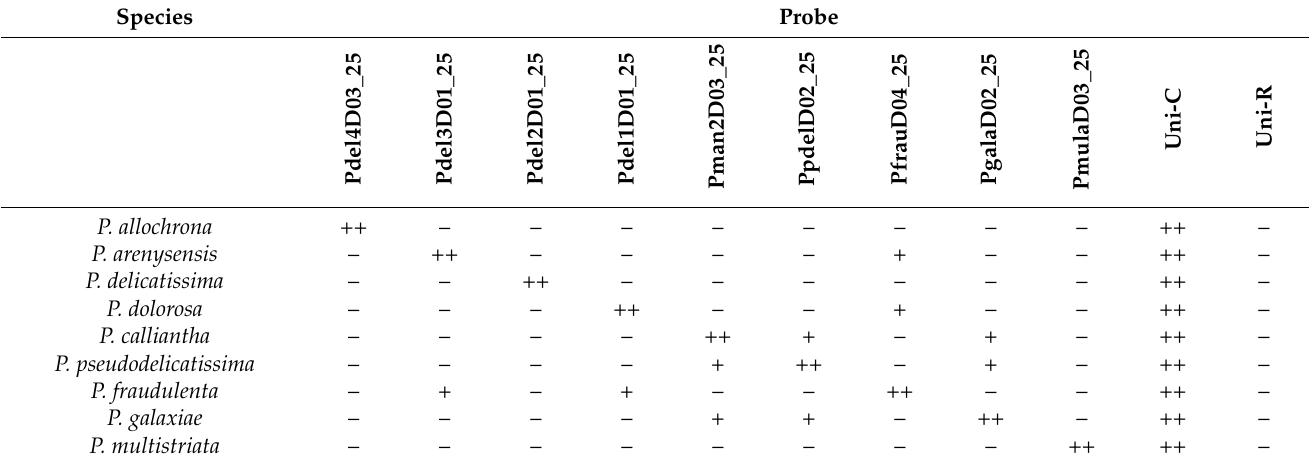
Table 3. Cross-hybridization trials. Specificity of probes against different Pseudo-nitzschia species. Probes that successfully hybridised were scored as positive “++” (highly visible) and “+” (weakly visible) under the epifluorescent microscope; probes that failed to detect a culture were scored as negative “–”.